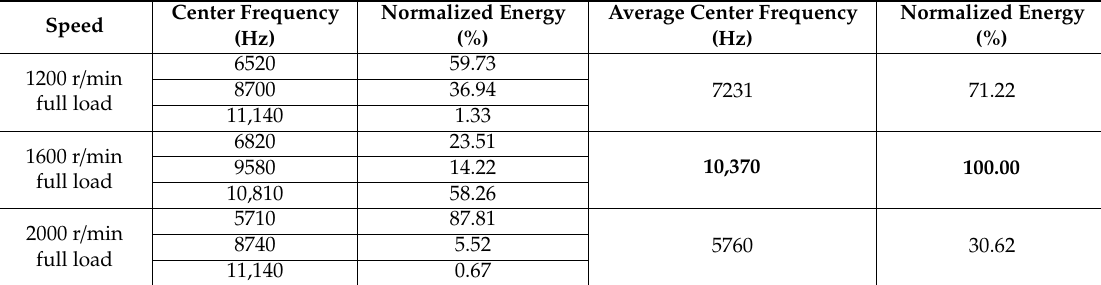
Table 5. Average Center Frequency and Normalized Energy of three characteristic speeds of full load. Center Normalized Speed Frequency (Hz)